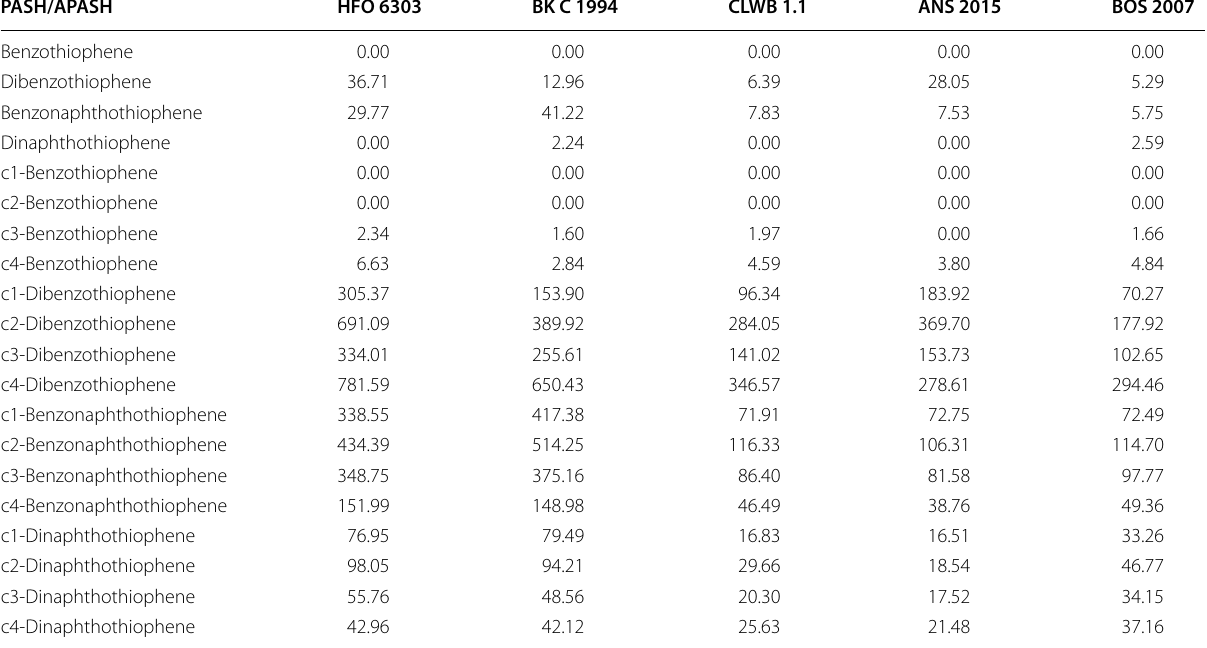
Table 3 PASH and APASH concentrations (µg/mL) in the weathered crude oil samples